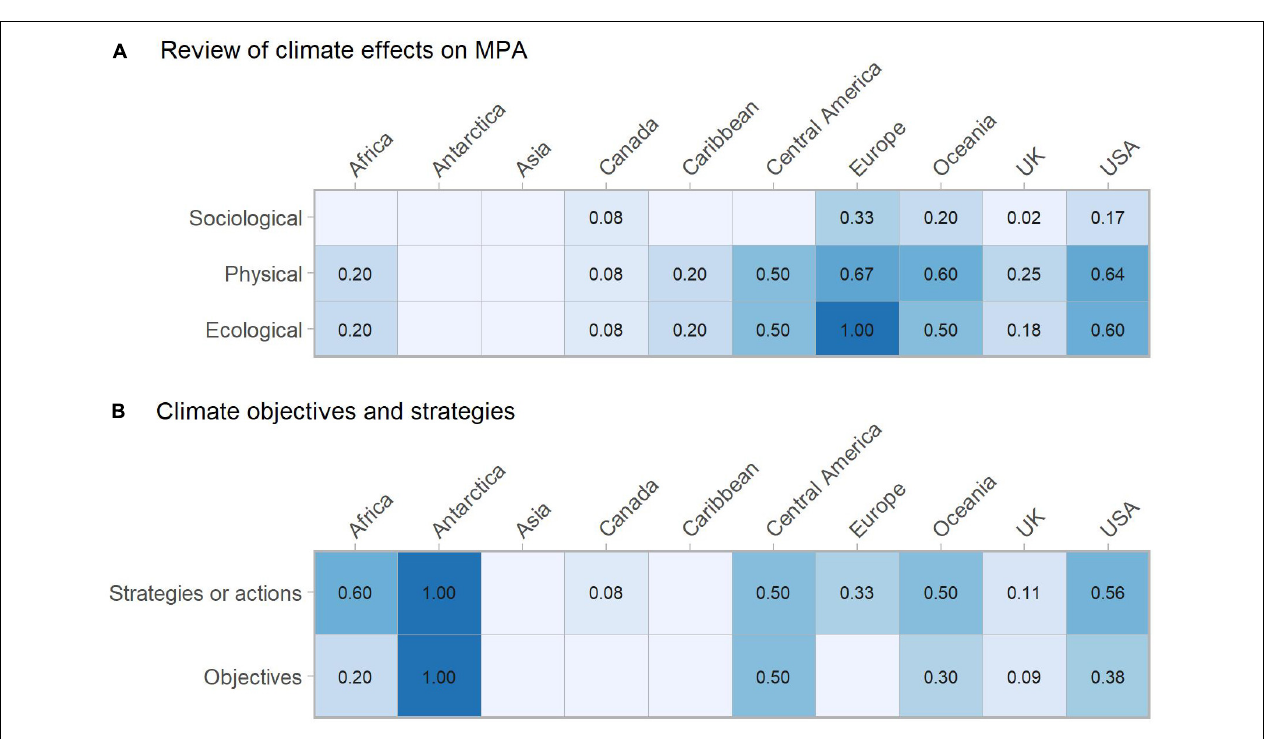
FIGURE 4 | The proportion of the 223 climate-considering MPA management plans that we manually reviewed that (A) discussed the likely impacts of climate change on the MPA/MPA network’s ecological, physical, or sociological components; and (B) included objectives or strategies pertaining to climate change